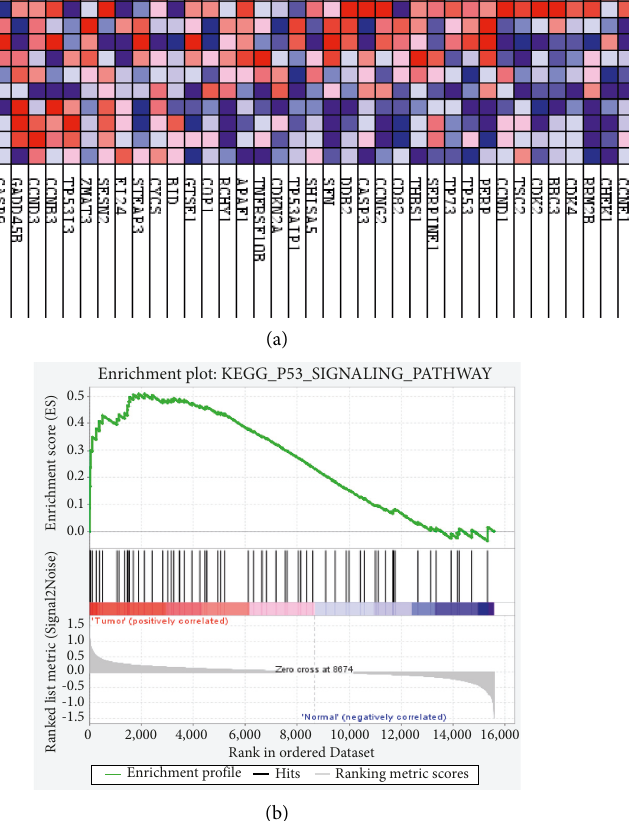
Figure 1: Figures display heatmaps and enrichment plots from GSEA. (a) Heatmap shows the name of groups in a row and the name of genes in a column. The red color in the heatmap and enrichment plot indicates a strong association between gene expression levels and the phenotype of BC. In contrast, the blue color shows a negative correlation between the level of gene expression and the phenotype of the normal breast. (b) The results of enrichment by GSEA show the major signaling pathways linked to the selected